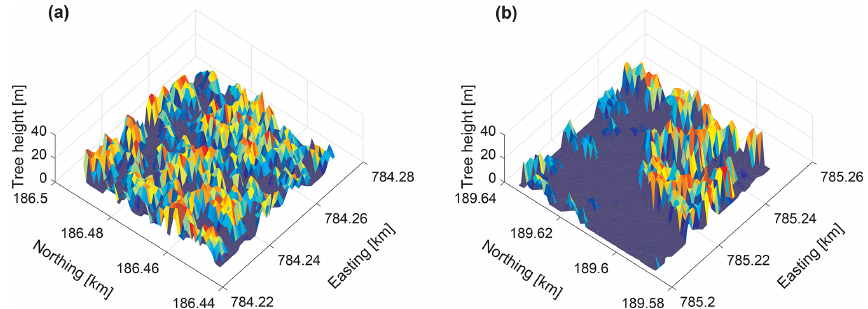
Figure 2. Canopy height models (CHM) for two 50m × 50m field sites in 1m grid resolution in the eastern Swiss Alps with (a) high canopy coverage and (b) low canopy coverage (for detailed site descriptions see Moeser et al.,